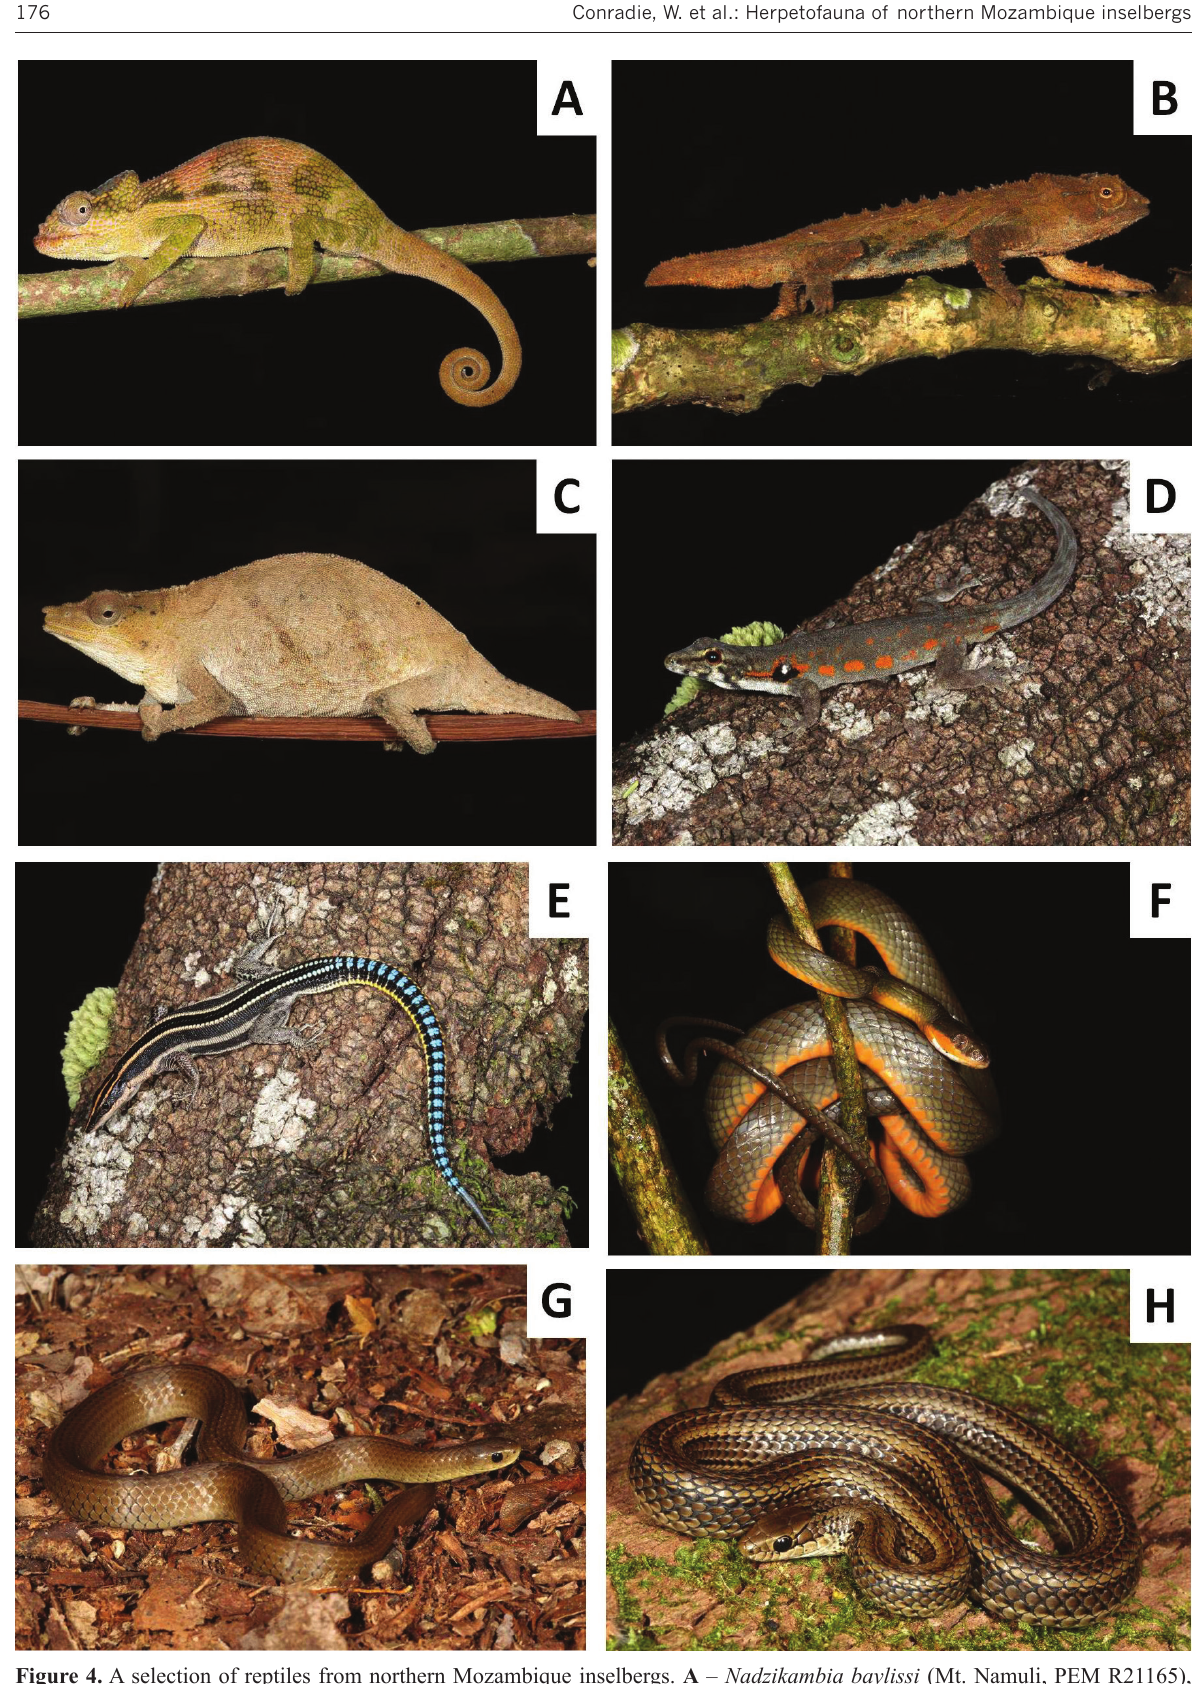
Figure 4. A selection of reptiles from northern Mozambique inselbergs. A – Nadzikambia baylissi (Mt. Namuli, PEM R21165), B – Rhampholeon tilburyi (Mt. Namuli, PEM R21157), C – Rhampholeon sp. (Mt. M’pàluwé, PEM R21209), D – Lygodactylus